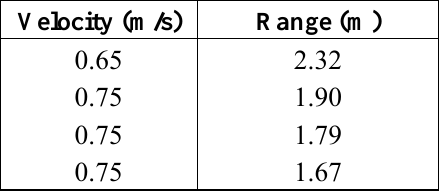
Table 5. Range and velocity estimation during tracking